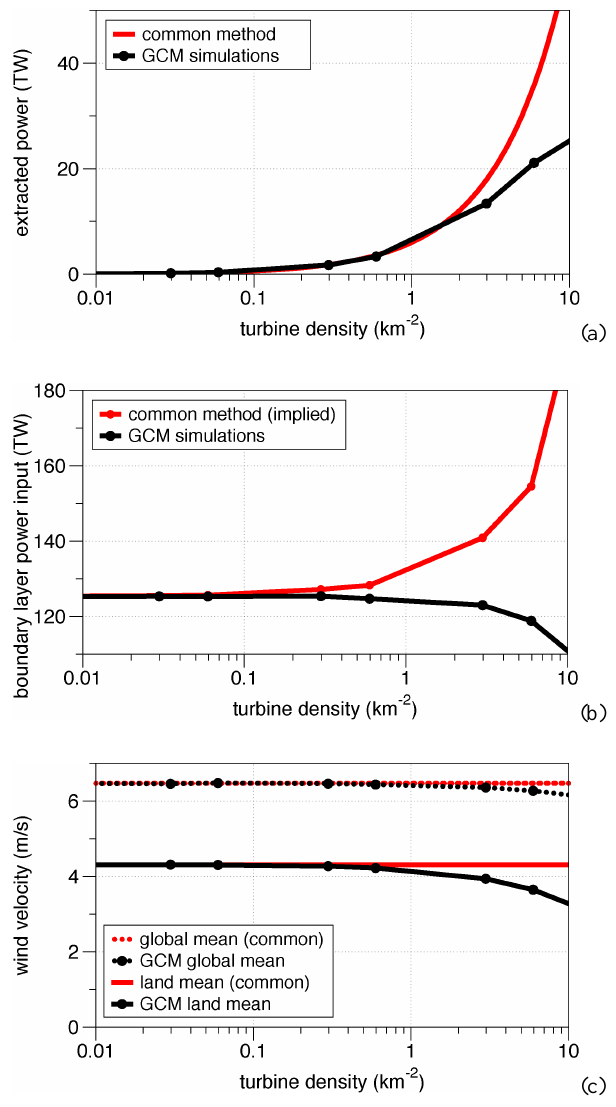
Fig. 4. Sensitivity of wind power extraction and consequences for boundary layer flow from a set of climate model simulations in which all land regions are populated by wind turbines of differ- ent density. Shown are (a) mean power extraction by wind turbines, (b) mean boundary layer kinetic energy import, and (c) mean global wind velocities, and mean land wind velocities. The estimates of the common method are depicted by red lines and as modeled by the GCM are shown as black lines. Note the divergence of the two lines starting at ≈ 2 turbines per km 2 , or a power extraction of 10% of the total kinetic energy import into the boundary